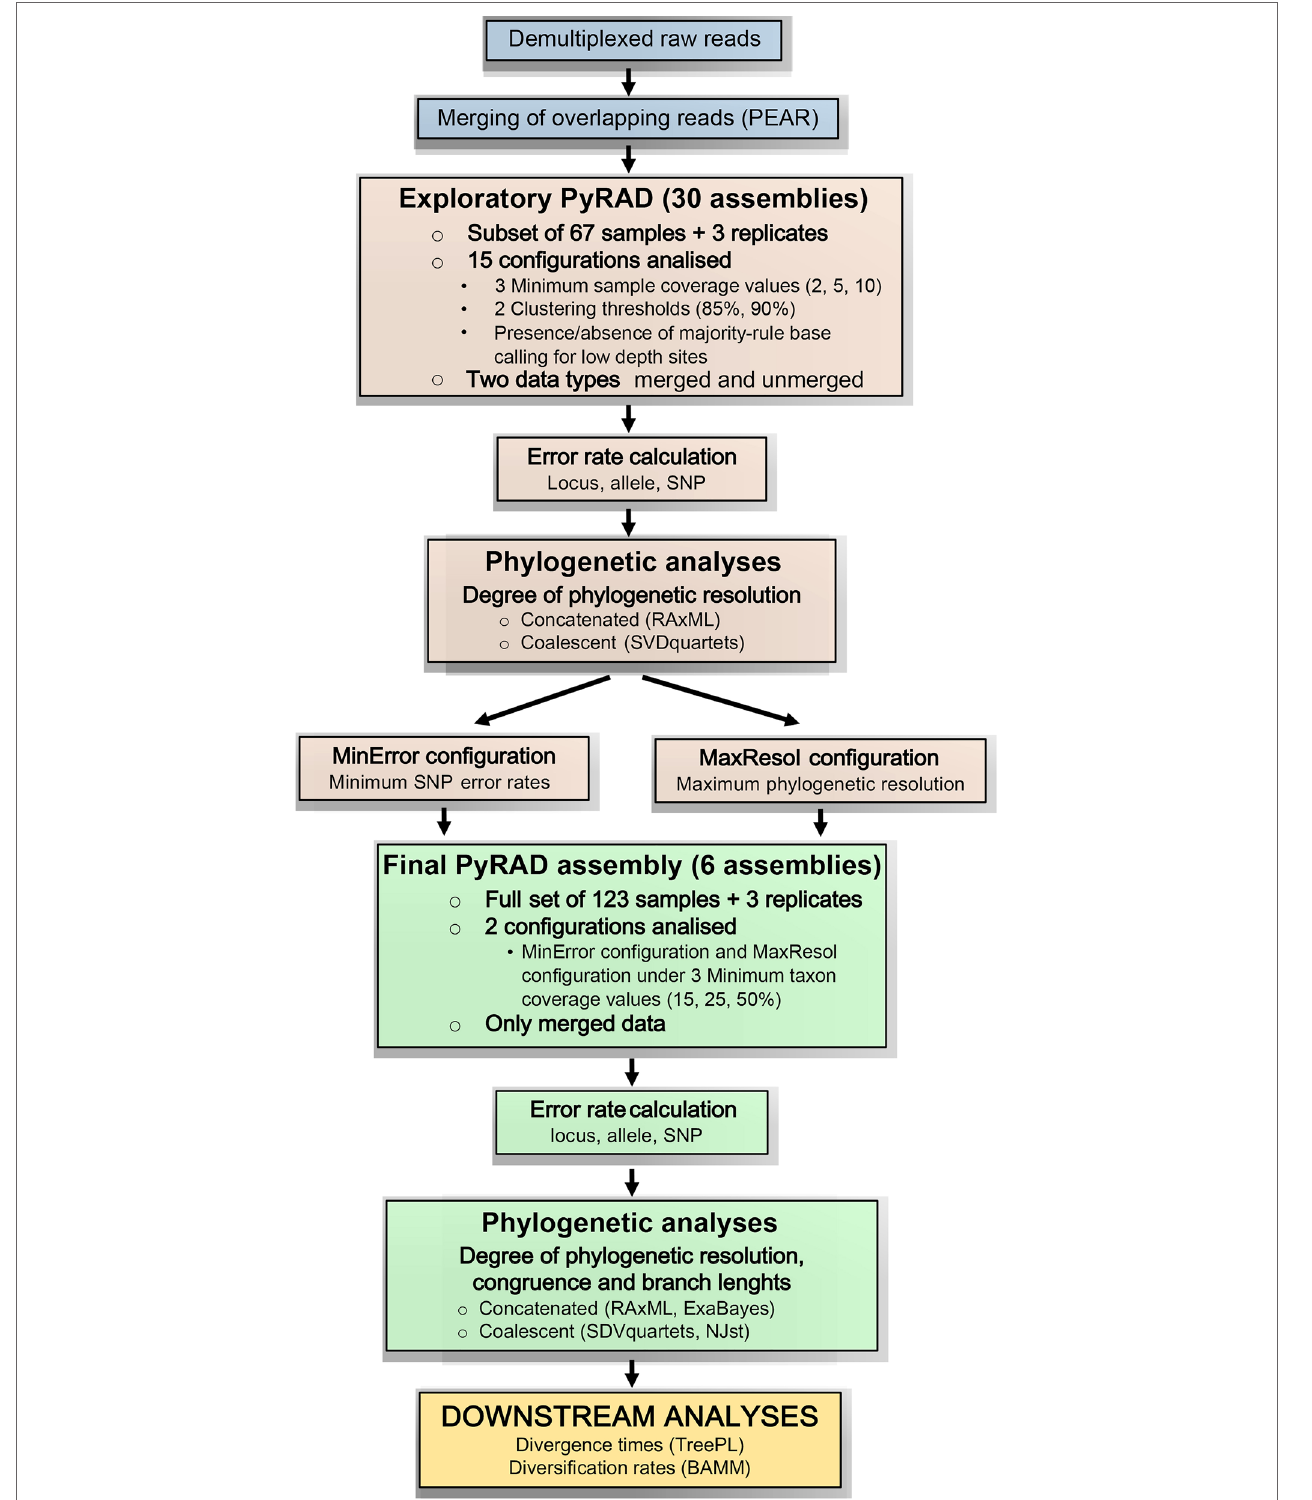
FIGURE 1 | Bioinformatic and analytical workflow used to process genotyping-by-sequencing (GBS) data for the genus Helianthemum (modified from Anderson et al., 2017). Blue rectangles represent the pre-processing of raw reads applied to all studied samples; brown rectangles represent the exploratory analyses applied to a subset of the studied samples; green rectangles represent the final analyses applied to the full set of studied samples; and the yellow rectangle represents the downstream analyses also applied to the full set of studied samples.